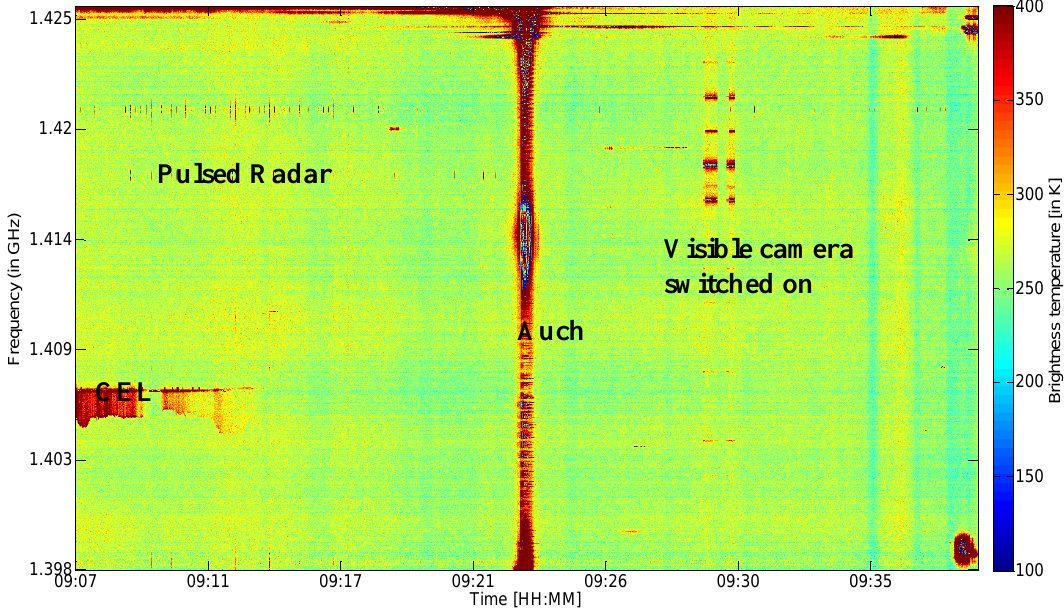
Figure 3. Time-Frequency representation of calibrated Tb values, during the flight from the Atlantic Ocean to Toulouse city